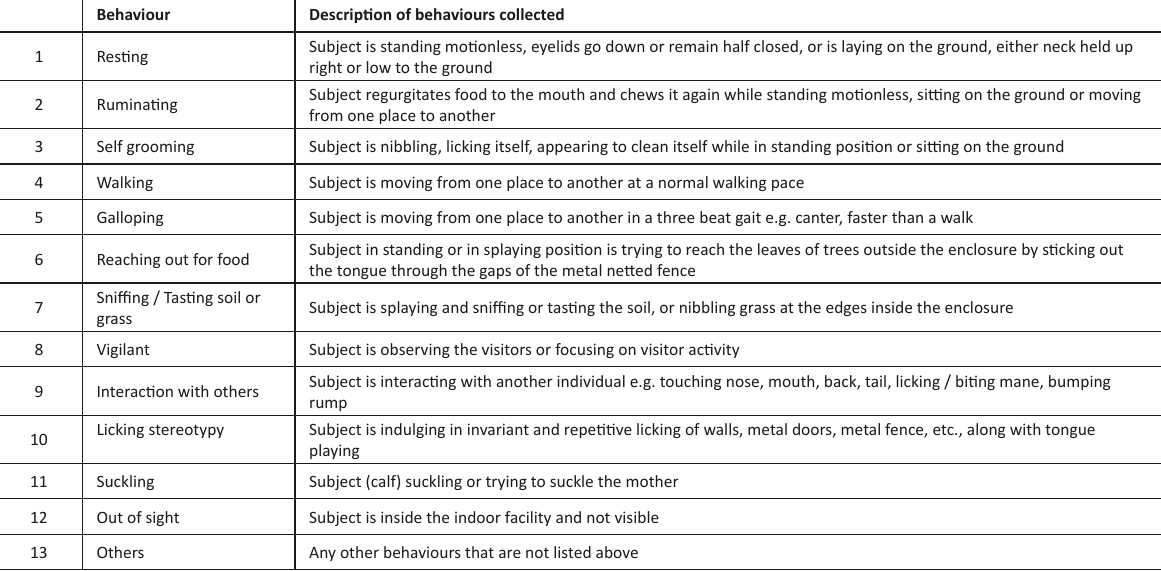
Table 2. Giraffe behaviour categories and descriptions recorded. Behaviour Description of behaviours